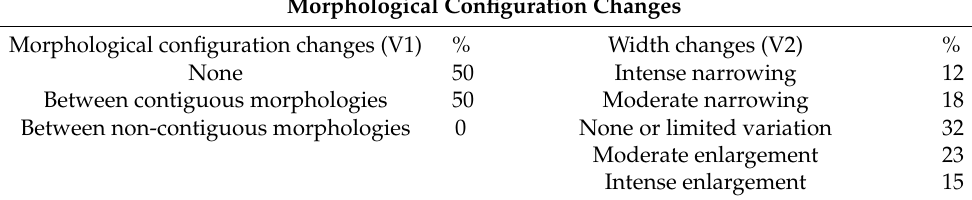
Table 9. Percentages of reaches that displayed morphological configuration changes in the Dittaino River (from 1954 to 2014).